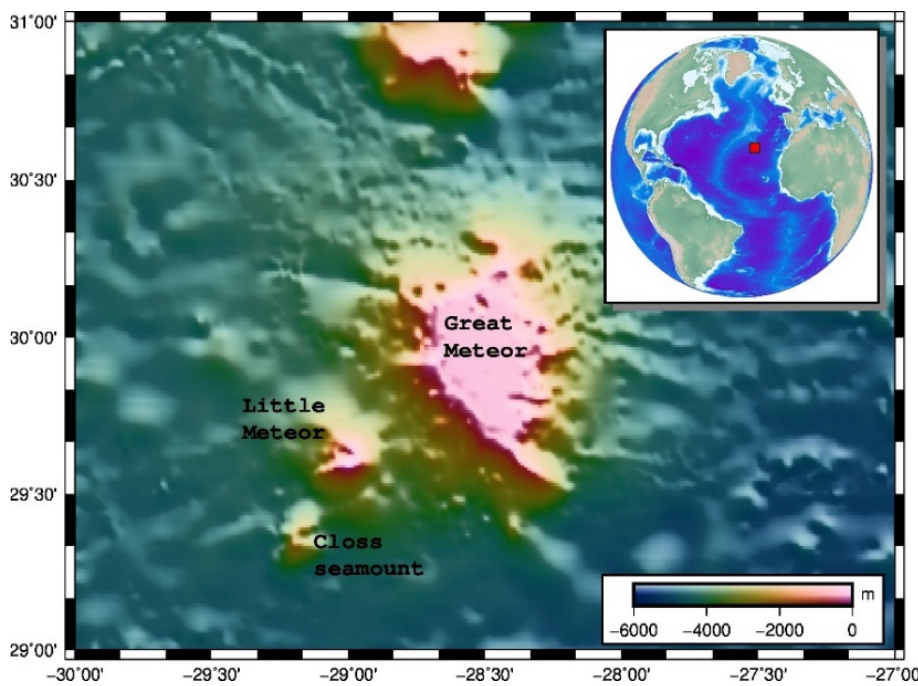
Figure 3. Great Meteor (GM), Little Meteor (LM) and Closs seamount (CL) localization. Seafloor depth from − 5311 m to − 26 m.